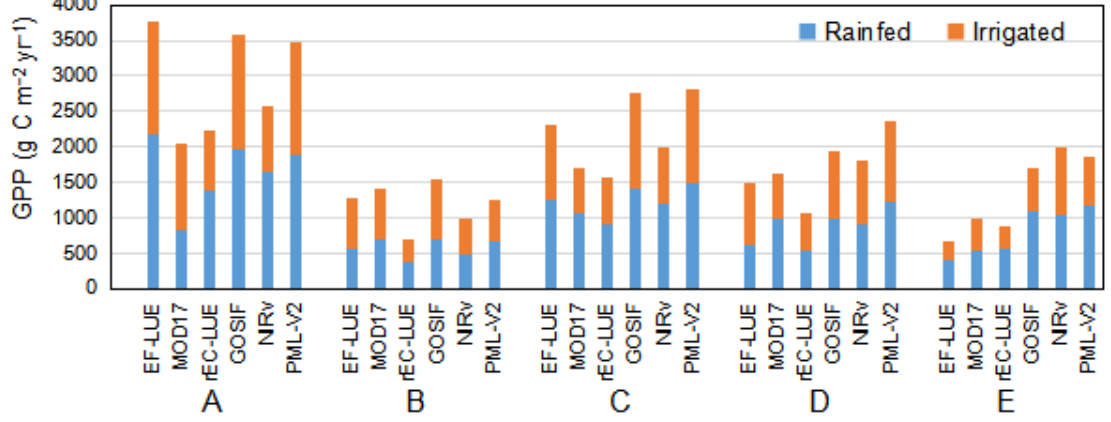
Figure 10. Comparison of annual mean GPP (2002–2018) from the EF-LUE model with other 5 GPP products in rainfed and irrigated croplands in tropical ( A ), arid ( B ), temperate ( C ), boreal ( D ), and polar ( E ) climate zones.